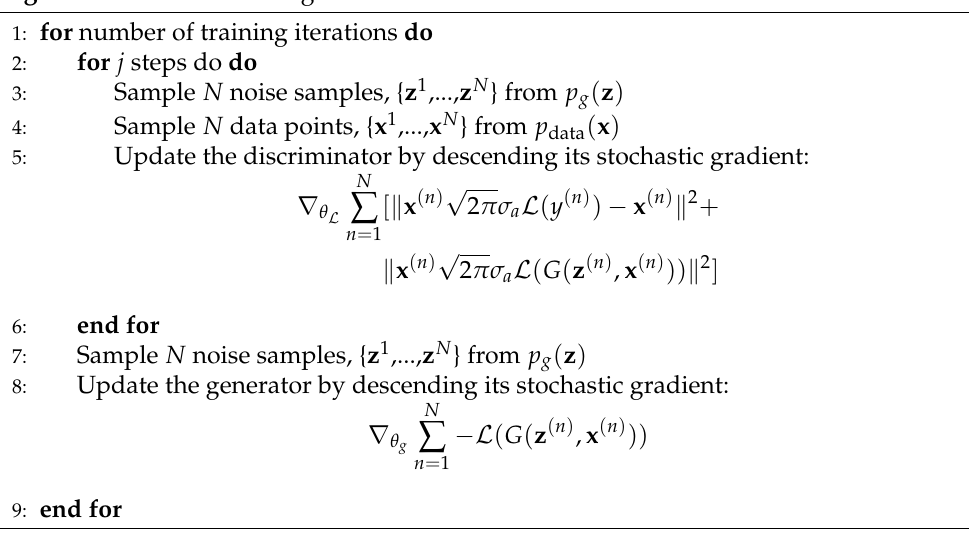
Algorithm 1 MD-CGAN